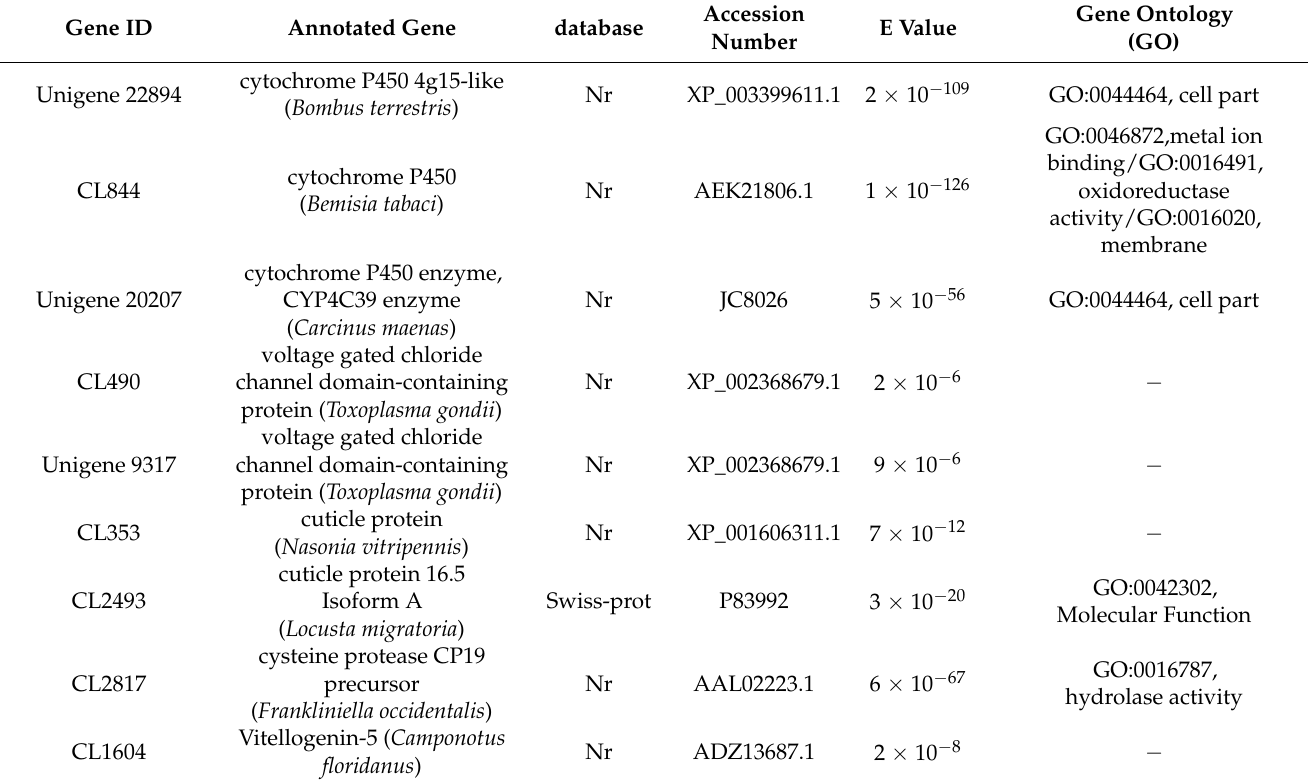
Table 5. The functional annotation information regarding the DEGs from Table